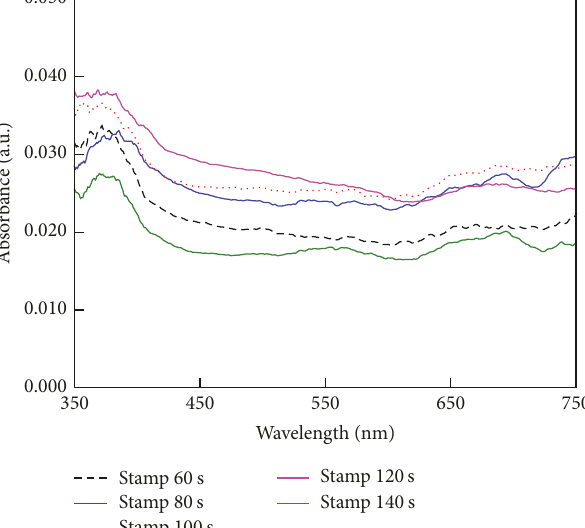
Figure 5: Absorption spectra of TPBi in different stamping times.